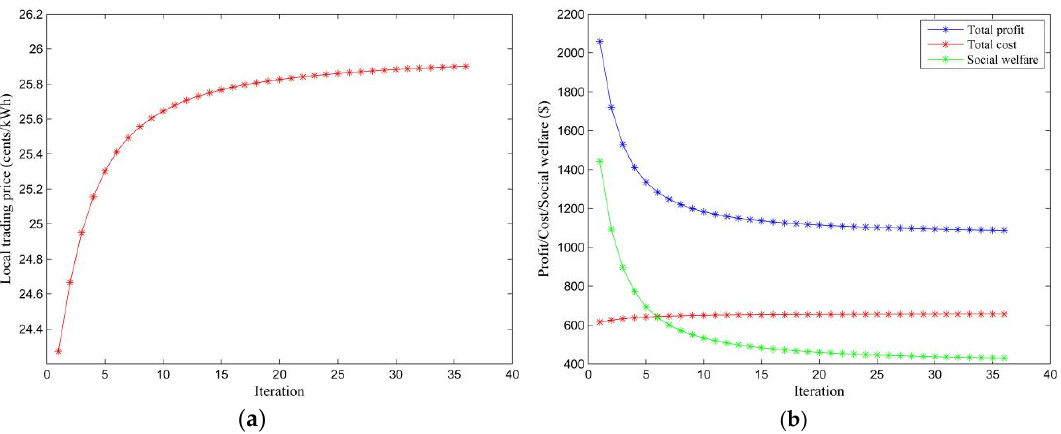
Figure 5. ( a ) Evolution of local trading price, and ( b ) comparison of total profit, total cost, and social